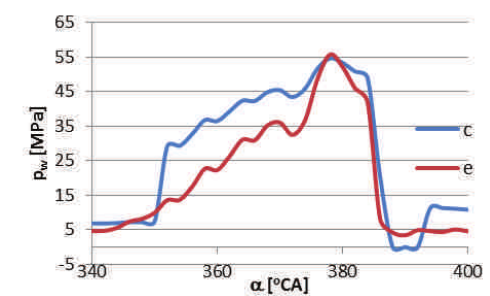
Fig. 11. Fragment of pressure courses in the injection pump measured in experimental studies (e) and calculated (c) for the 100% of the engine